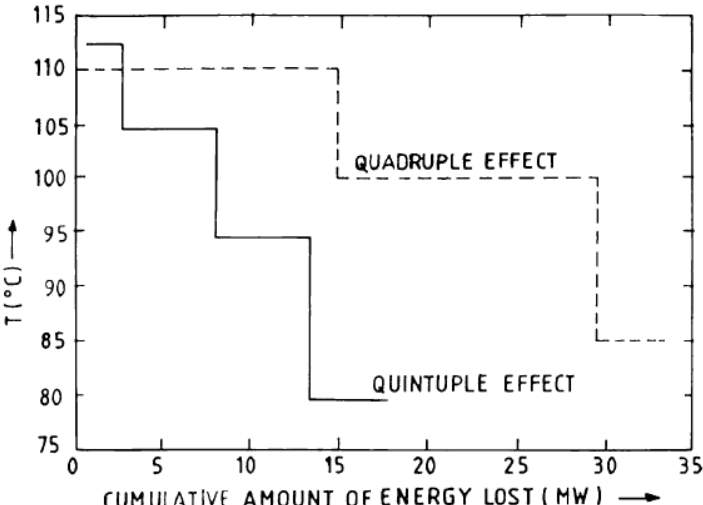
Figure 1. Comparison of the amount of exergy lost. Reprinted with permission from [26]. Copyright 2022 Elsevier. Table 3. Performance categories and